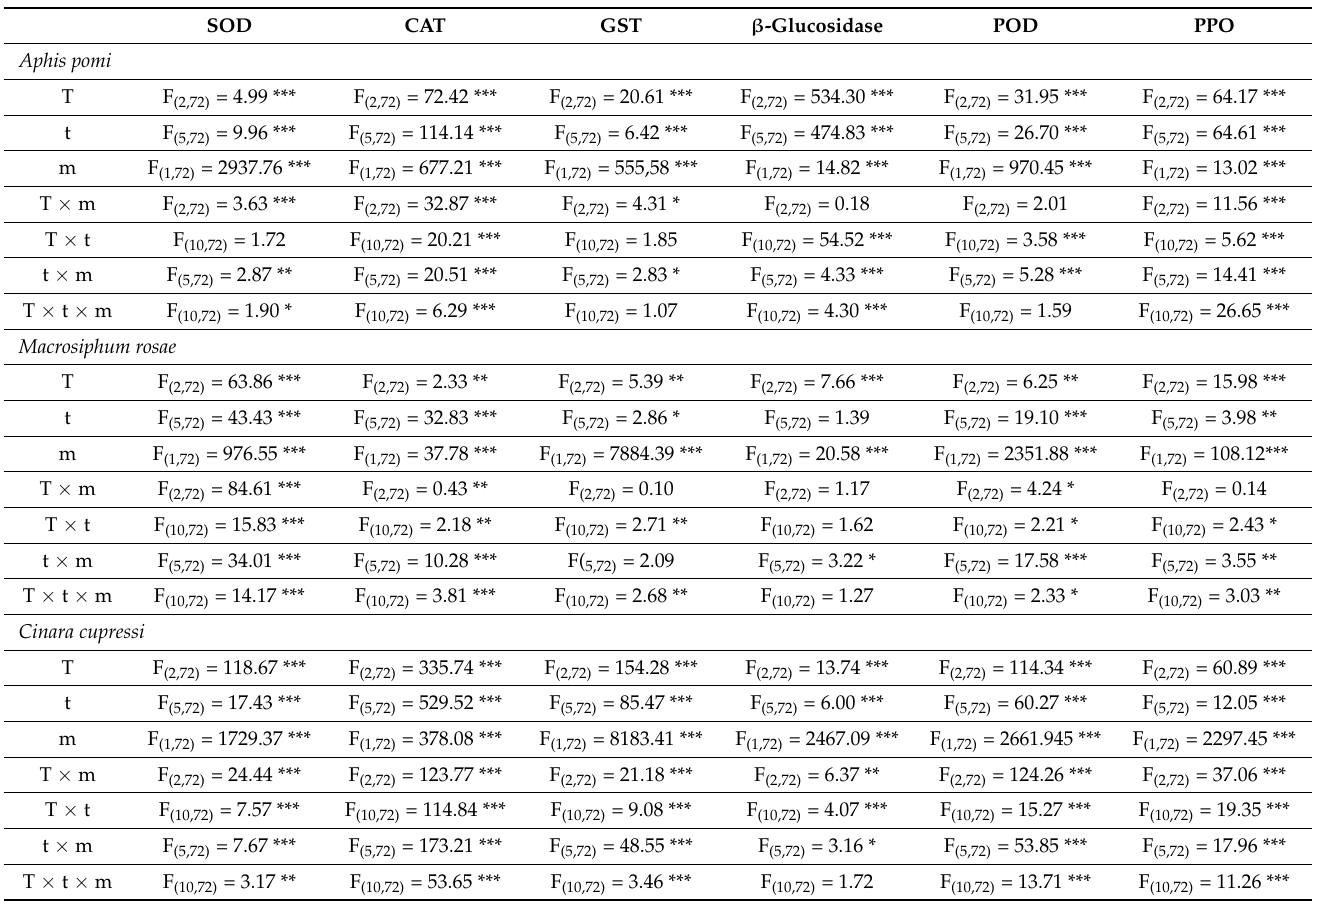
Table 1. Analysis of enzymatic activity in the tissues of three species of aphid: Aphis pomi , Macrosiphum rosae and Cinara cupressi . ANOVA was used to test differences between average enzymatic activities in different conditions ( p < 0.05). (T—temperature, t—time, m—type of